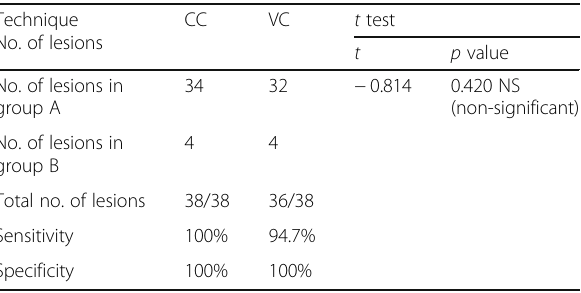
Table 7 Comparison between CC and VC and their sensitivity and specificity regarding the number (No) of lesions detected in both patient groups Technique CC VC No. of lesions